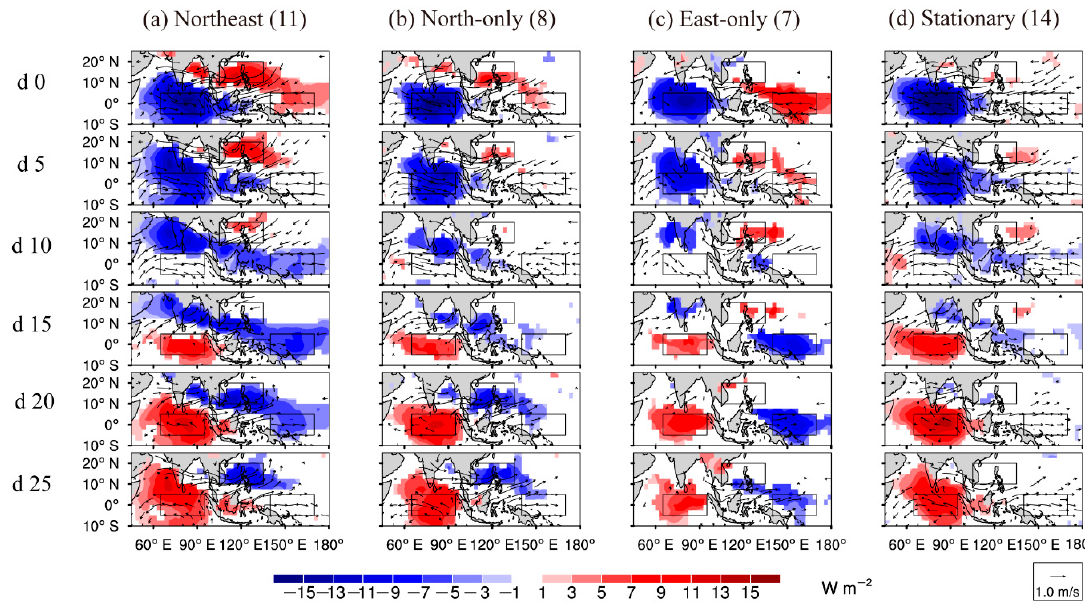
Figure 3. Spatial–temporal OLR evolution characteristics of the four modes. Evolution of the regressed OLR anomalies (shading; W m − 2 ) and 850-hPa wind anomalies (vector; m / s) from day 0 to day 25 for ( a ) northeast mode, ( b ) north-only mode, ( c ) east-only mode, and ( d ) stationary mode. Only anomalies above 90% significance by Student’s t test are plotted.